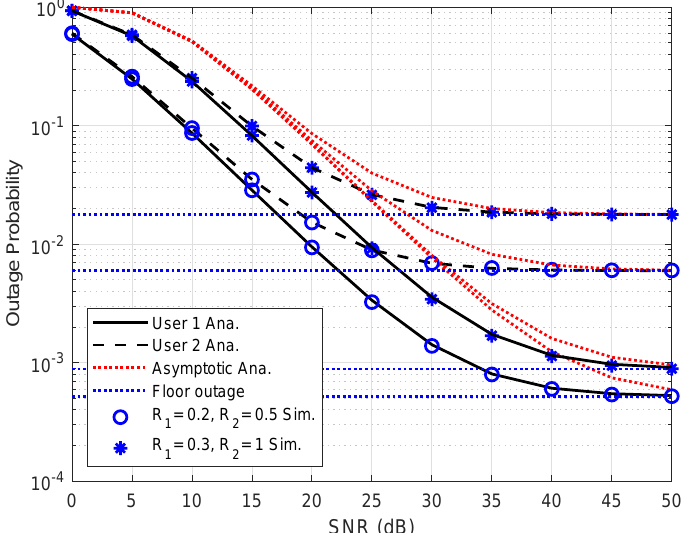
Figure 4. Outage probability of User 1 and User 2 versus SNR.